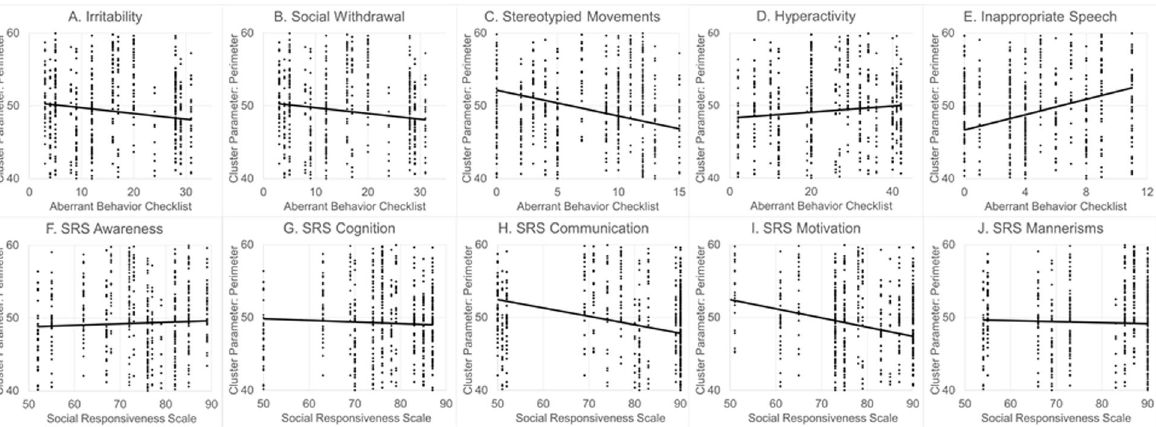
Fig. 7 The relationship between ASD symptoms and behaviors for mitochondrial cluster perimeter. Both ( B ) Social Withdrawal and ( C ) Stereotyped Movements on the Aberrant Behavior Checklist (ABC) were signi fi cantly better with higher mitochondrial cluster perimeter.